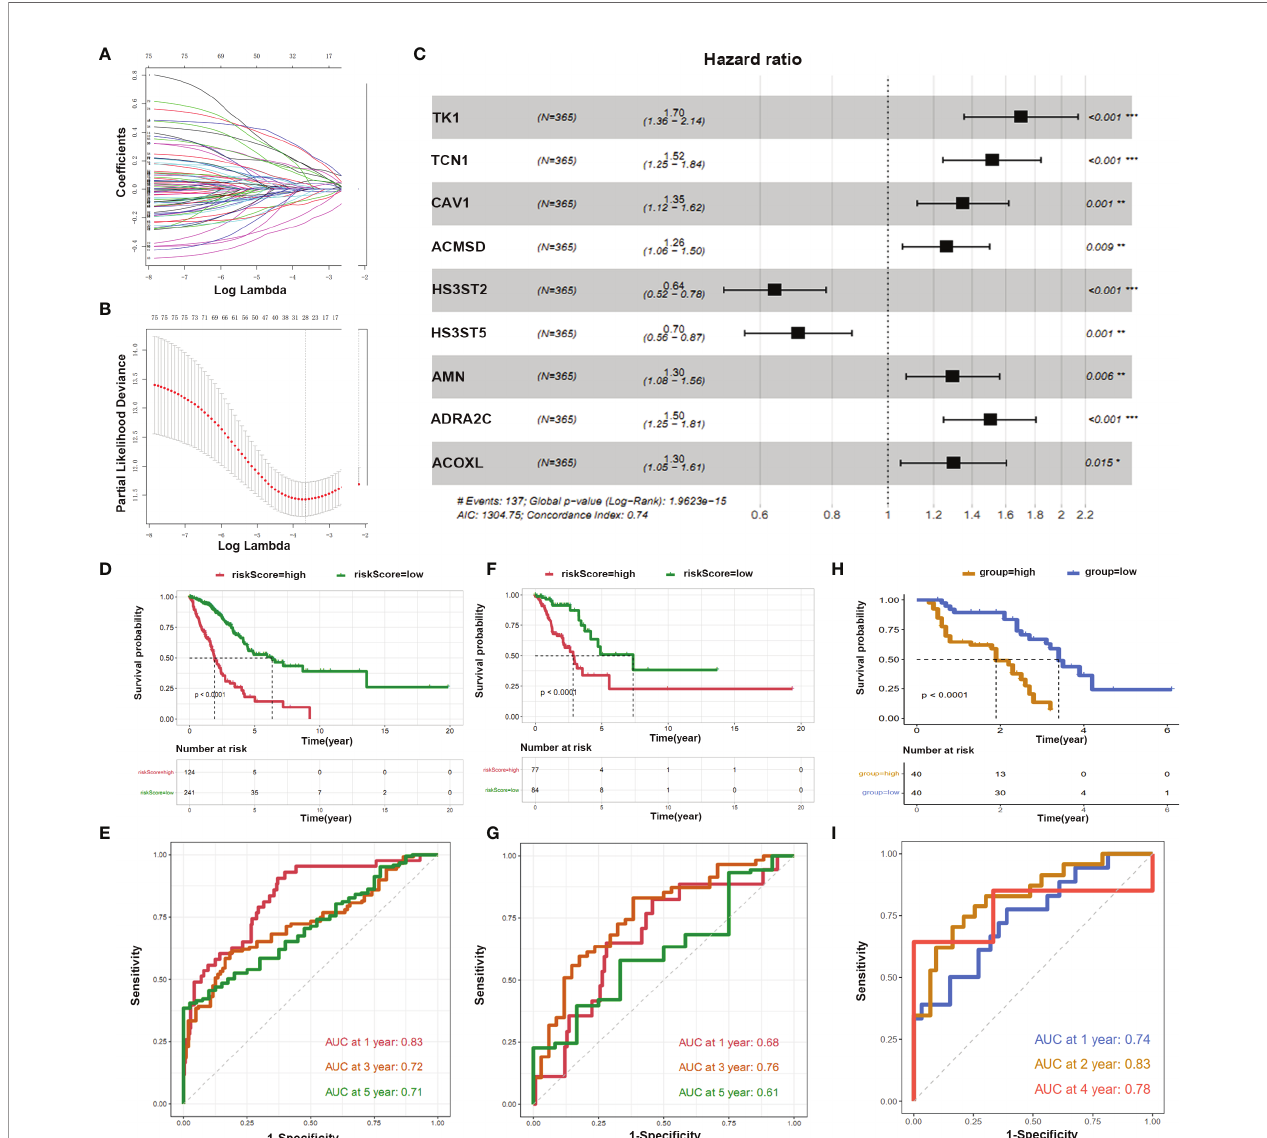
FIGURE 6 | LASSO and hub genes of prognostic model. (A, B) Optimal values of the penalty parameter l ; (C) Multivariate regression analysis of nine genes we shown; (D, F, H) OS in the low score group was signi fi cantly higher than in the high score group; (E, G, I) Time-dependent ROC curves analysis of the prediction